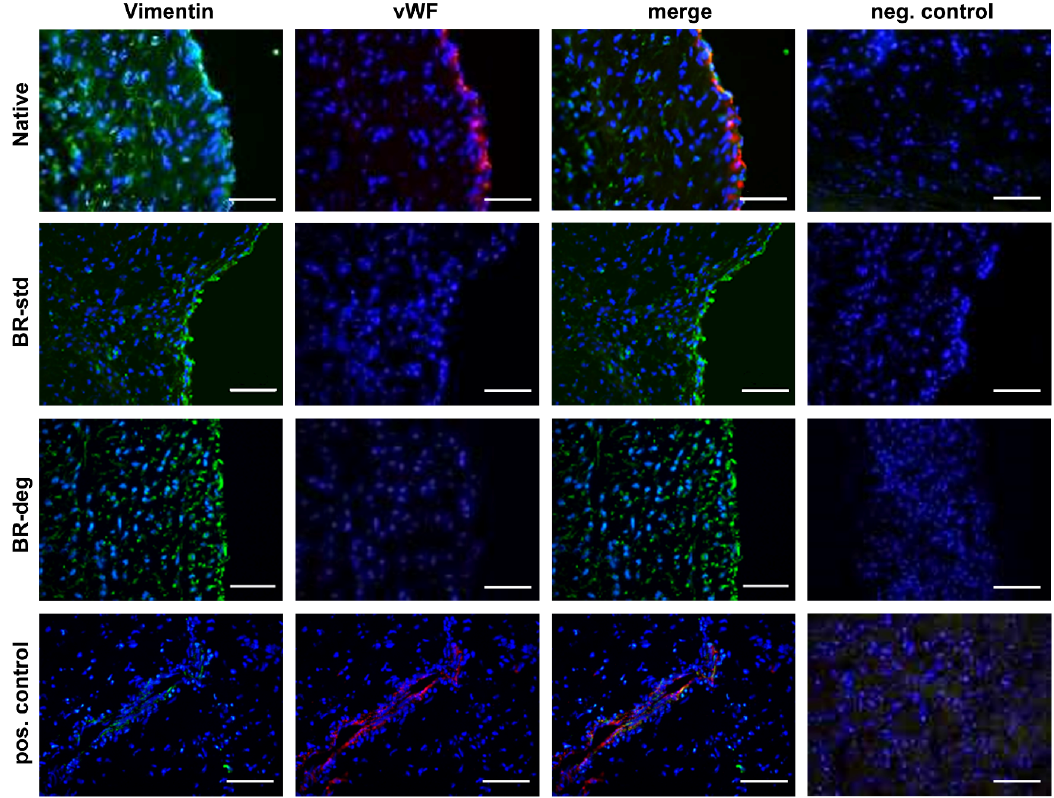
Figure 4. Cellular composition of the aortic valve after bioreactor cultivation. Immune staining with vimentin (green) and vWF (red) specific antibodies was performed on aortic valve cross-sections. Vimentin positive cells were detected in native tissue (first panel) as well as after one week of bioreactor cultivation in standard (BR-std, second panel) pro-degenerative medium (BR-deg, third panel). vWF staining is visible in native aortic valve leaflets (Native, first panel), but not after bioreactor cultivation (second and third panel). Nuclei were counterstained with DAPI. Blood vessels in myocardial specimens served as positive staining control (last panel). Negative control was performed by staining without primary antibodies (right column). Representative pictures of five replicates were chosen. Bars: 50 µm.